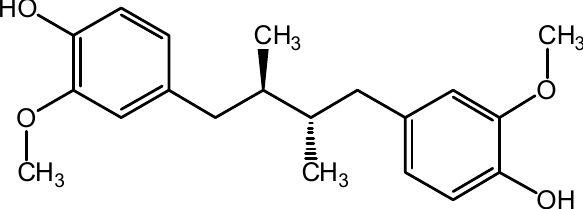
Figure 1. Lignan meso -dihydroguaiaretic acid with antimycobacterial